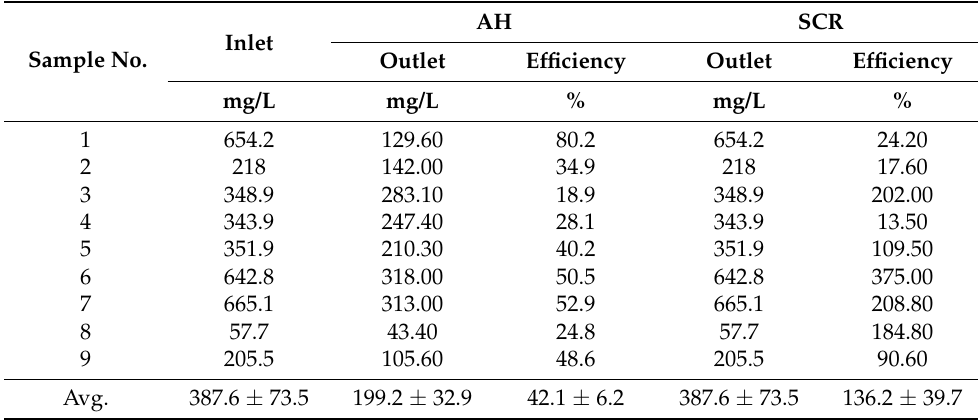
Table 8. Inlet and outlet TSS and removal efficiencies at preliminary stage.